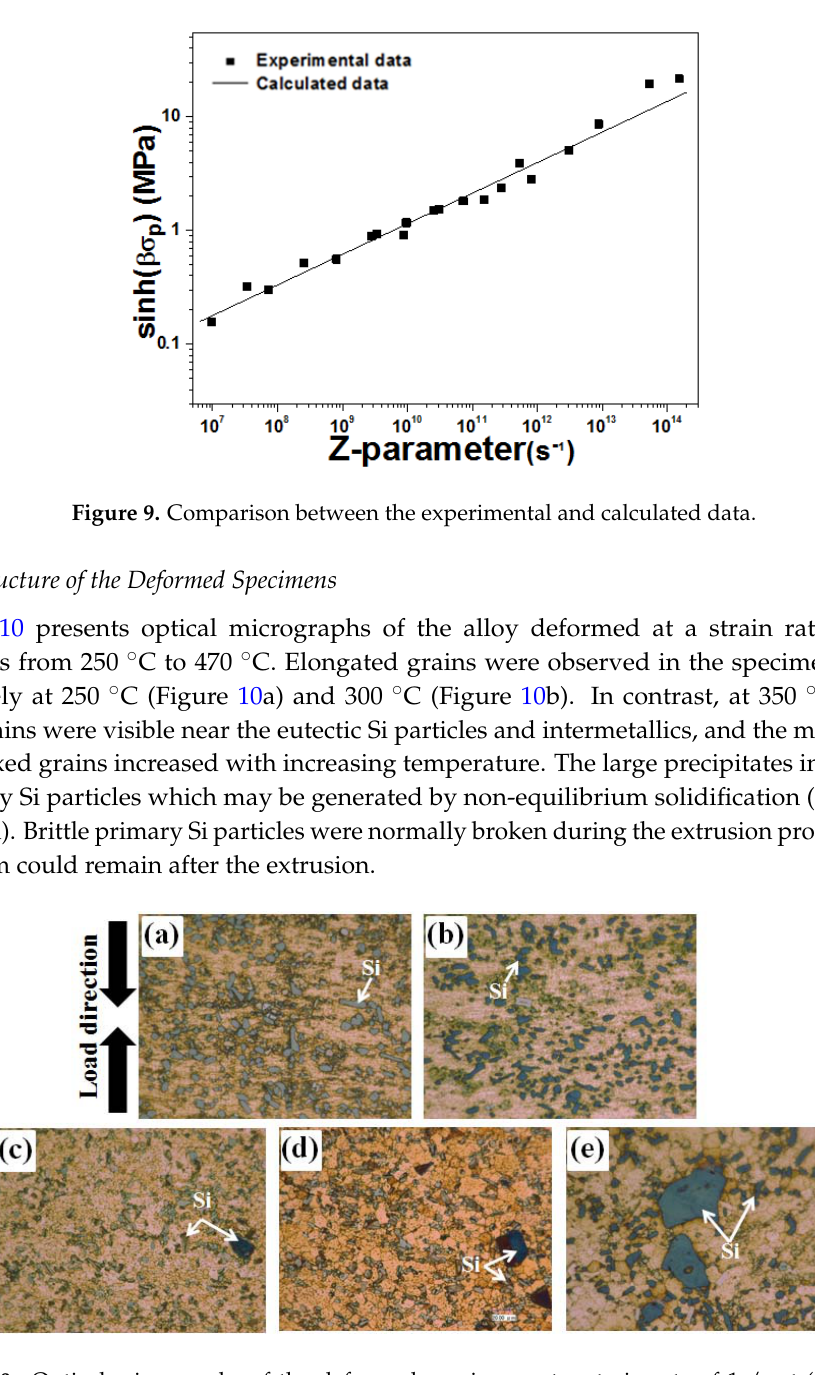
Table 3. Mean grain size ( μ m) after deformation under different test conditions.